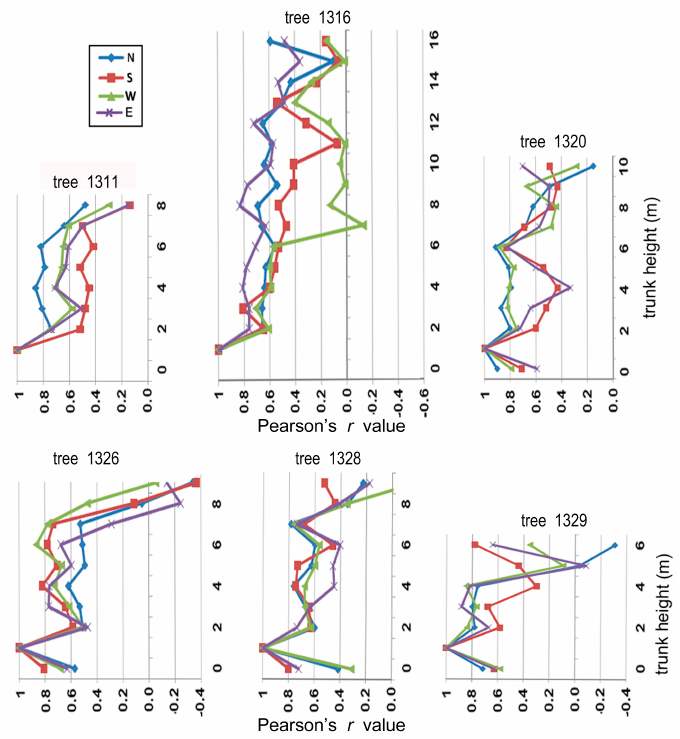
Figure 21. Variation in Pearson’s r values produced by correlating radial series at 1 m trunk height with those of corresponding chronology and the same cardinal direction at other trunk heights.